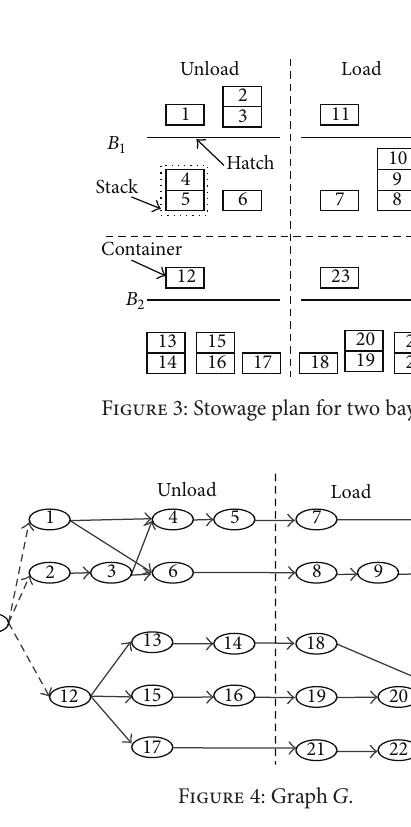
Figure 2: Top view of DGBC.